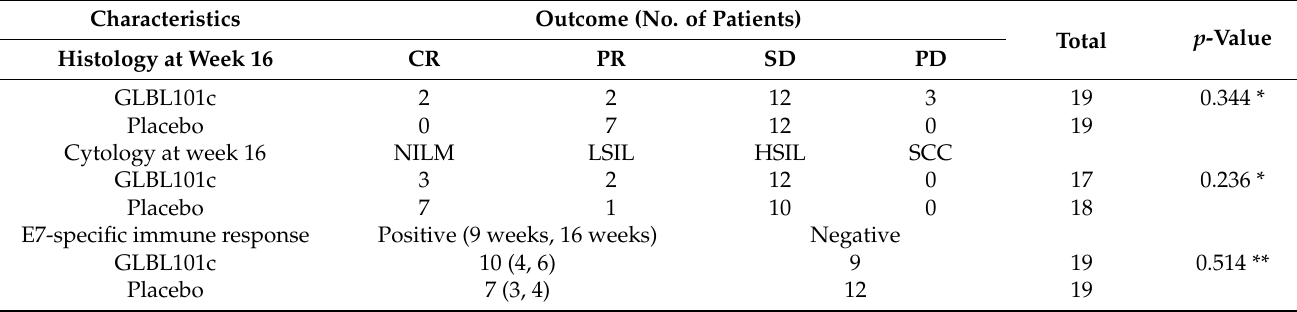
Table 3. Clinical and immune